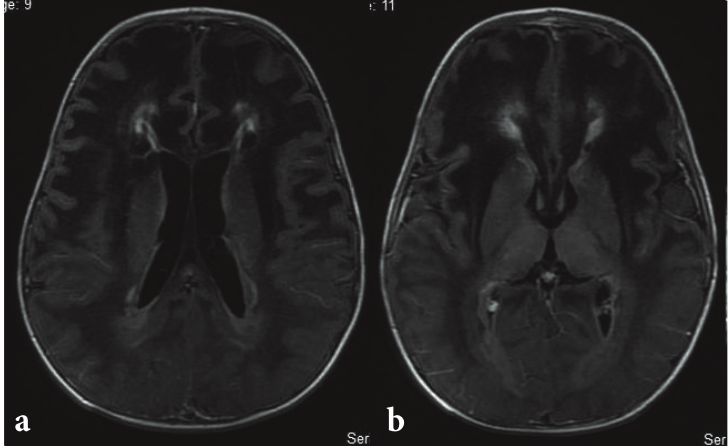
a Fig. 4. Post-contrast T1W images show symmetrical enhancement of the periventricular rim, deep frontal white matter and heads of the caudate nuclei.